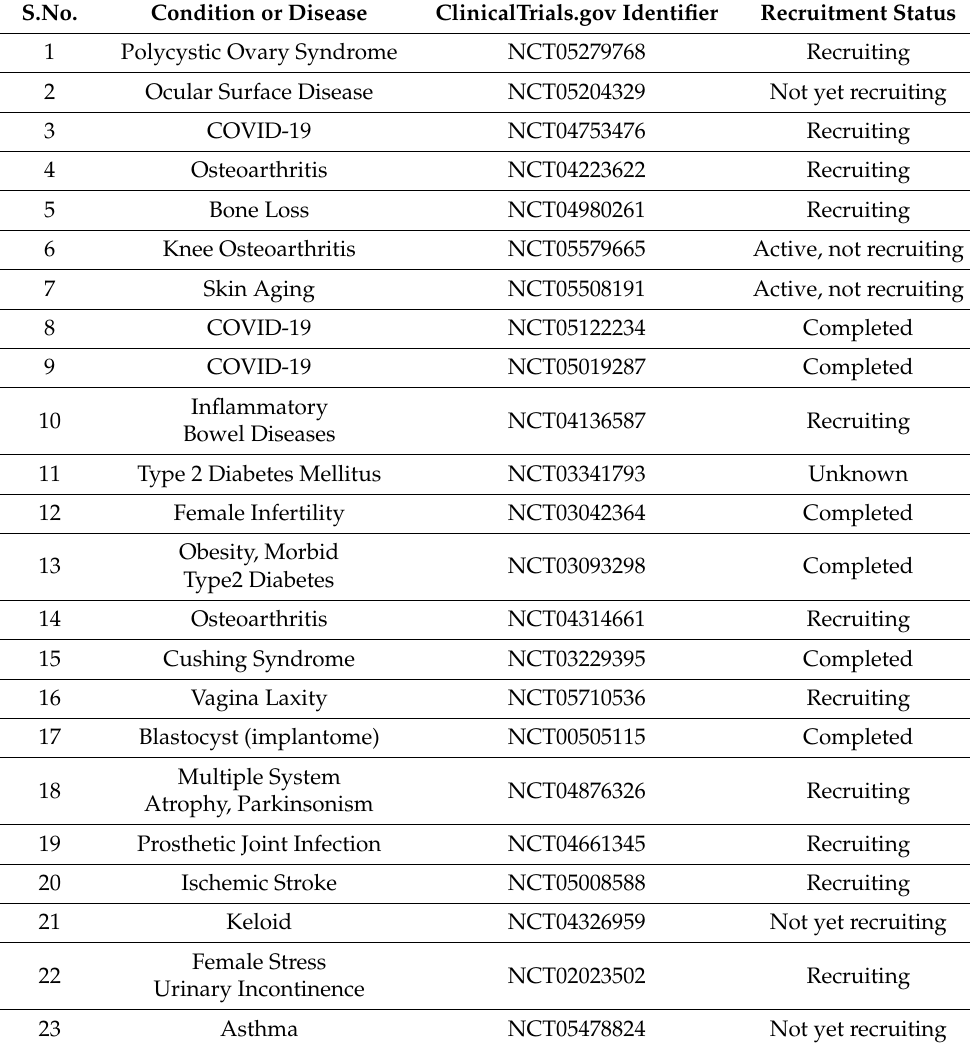
Table 1. Clinical studies investigating the safety and potential of secretomes in different health conditions and diseases.